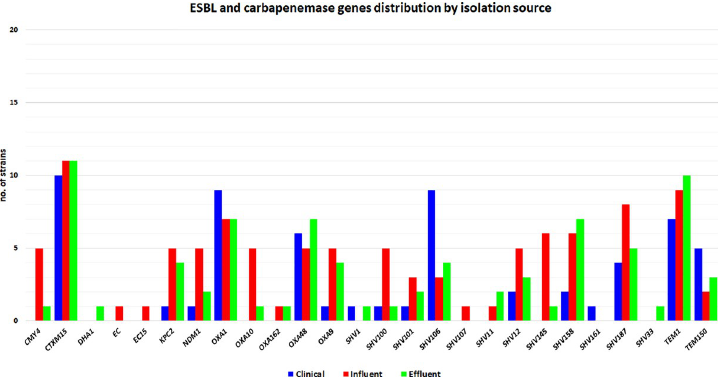
Fig 1. Beta-lactam resistance genes detected in the K . pneumoniae isolates from wastewater and the corresponding clinical settings.